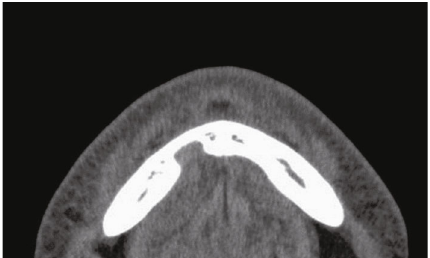
Figure 3: Computed tomography (CT) image, horizontal cross section, soft tissue mode. The inside of the cavity in the lingual side of the mandible has similar soft tissue density (CT number, 40 – 70 Houns fi eld units (HU)) to the sublingual glands (CT number, 40 – 70HU), with fi ndings that suggest continuity with the sublingual glands.